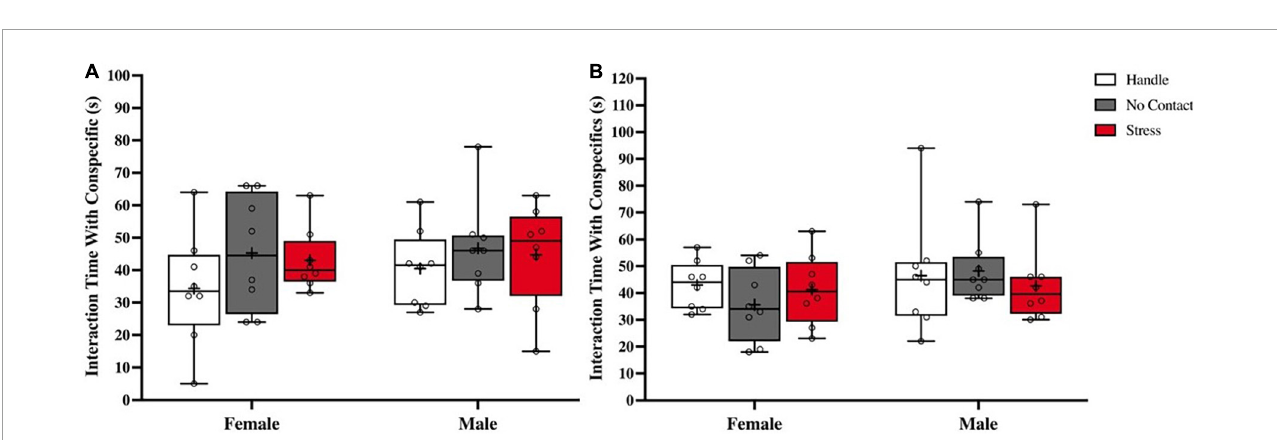
FIGURE4 Interaction time is not altered by preadoelscent exposure to unfamiliar male. Total time interacting (M ± Minimum and Maximum) with conspecifics. (A) Time spent interacting with conspecific during acquisition showed no differences based on condition nor sex. (B) Time spent interacting with both conspecifics during social memory test showing no differences in time spent interacting with both the familiar and novel conspecifics across conditions or